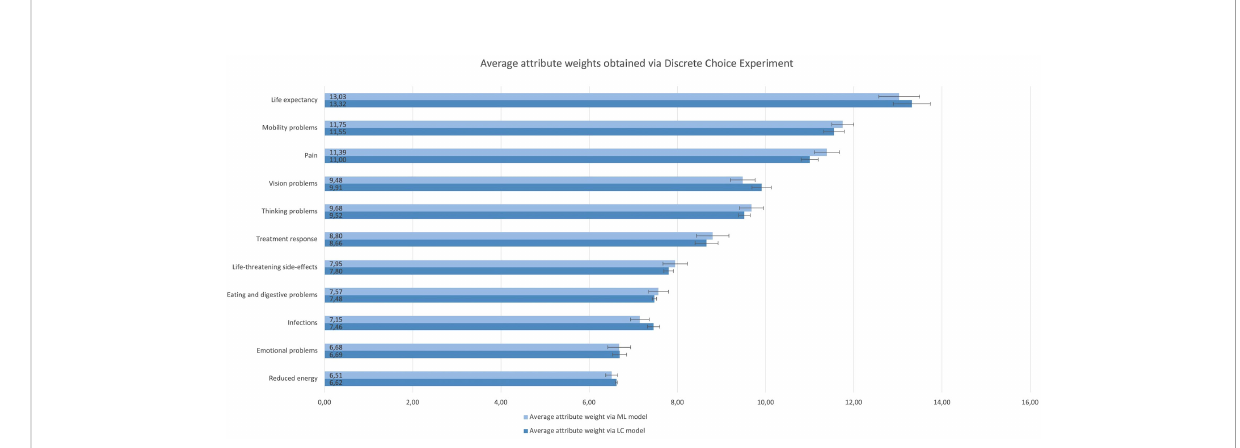
FIGURE 2 Rank order and relative importance of the attributes obtained via the Discrete Choice Experiment choice tasks and analysed using a Mixed Logitmodel (light) and Latent Class model (dark). The attributes are listed from their highest to lowest average relative